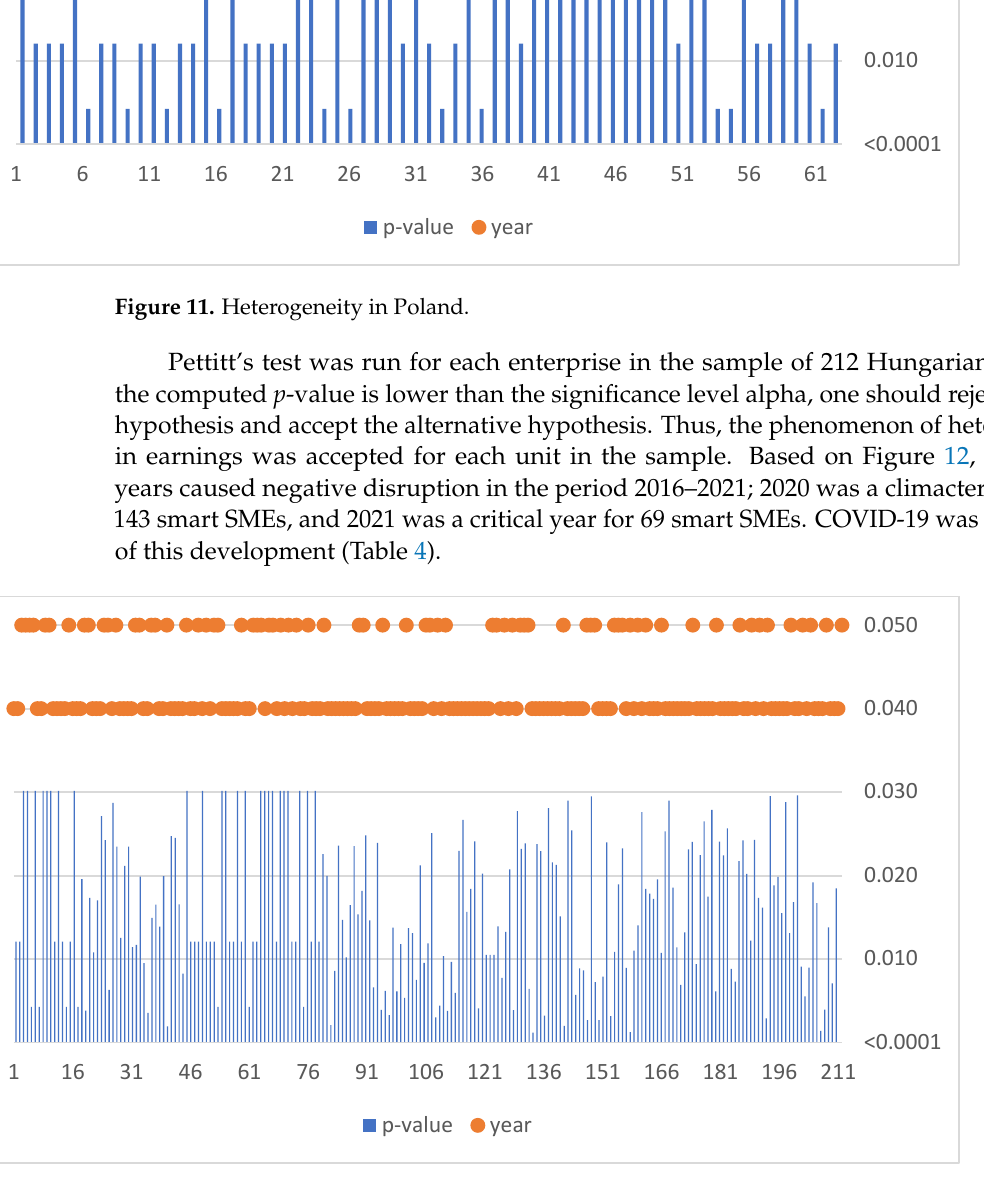
Figure 12. Heterogeneity in Hungary.